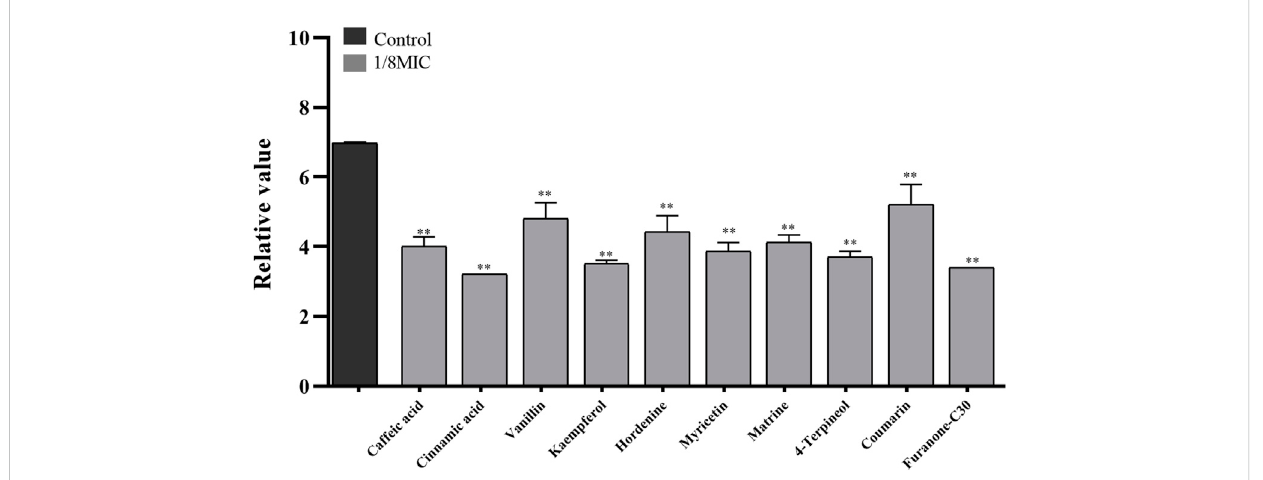
FIGURE 3 Effectof9TCMMsontheadhesionability ofXDRABstrainsat1/8MIC(x±s, n =12).TCMMs,traditionalChinese medicinemonomers;MIC,minimal inhibitory concentration; XDRAB, extensively drug-resistant A. baumannii; **, p < 0.01.